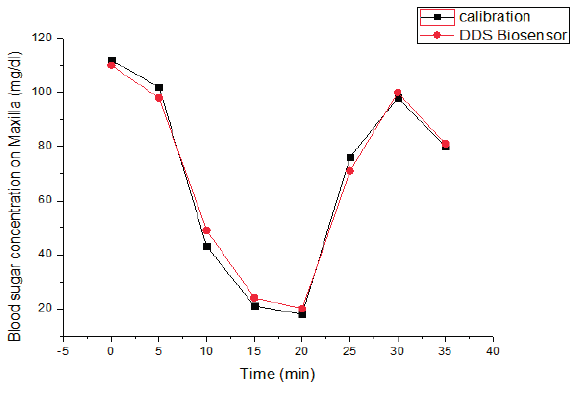
Figure 10. The temporal variation of blood sugar levels measured by the proposed intra-oral implant system and ACCU-CHEK ® blood sugar